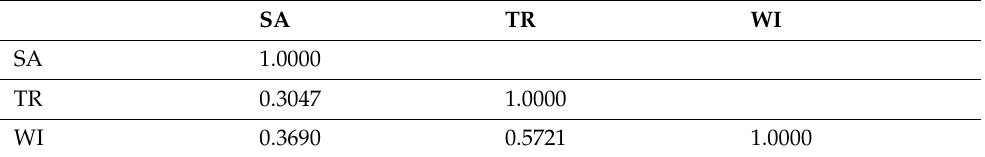
Table 4. Correlation matrix for stock return